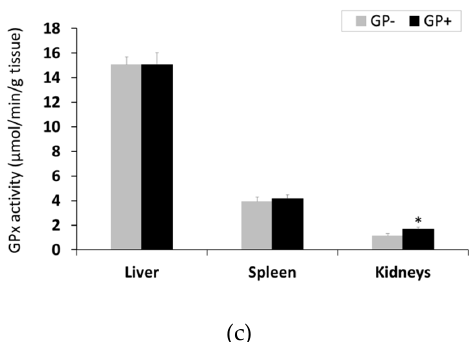
Figure 3. Antioxidant activity in the liver, spleen and kidneys samples (n = 10) as determined by: Catalase (CAT) activity (μmol/min/g tissue) ( a ), superoxide dismutase (SOD) activity (U/g tissue) ( b ), glutathione peroxidase (GPx) activity (μmol/min/g tissue) ( c ); * = statistically significant when GP− was compared with GP+.